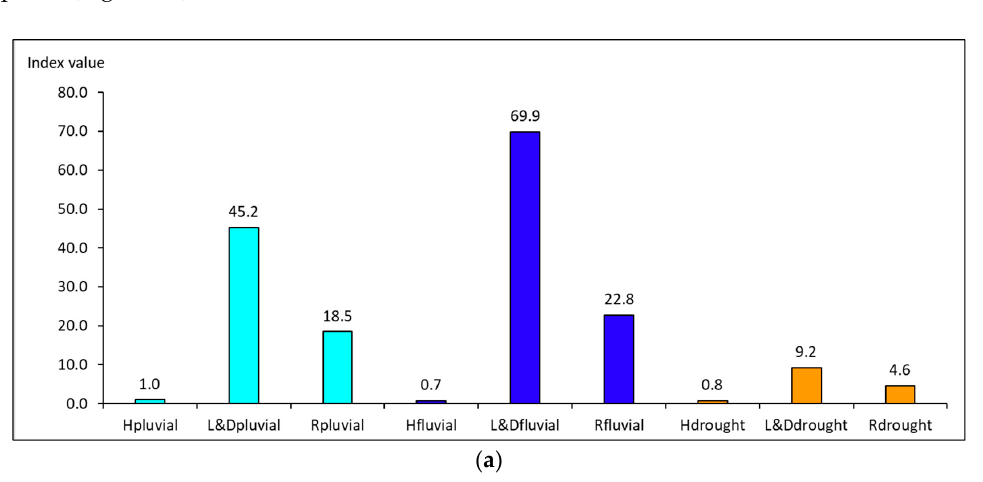
Table 3. Factors contributing to disastrous floods and drought as ascertained in Falmey, Guéchemé, Kiéché, Tessa, and Tounouga municipalities in July 2018.